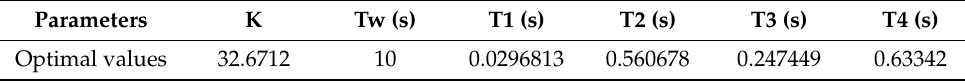
Figure 5. Optimally sized power system stabilizer lead-lag structure. Table 3. Optimal parameter values of power system stabilizer employing ALO .